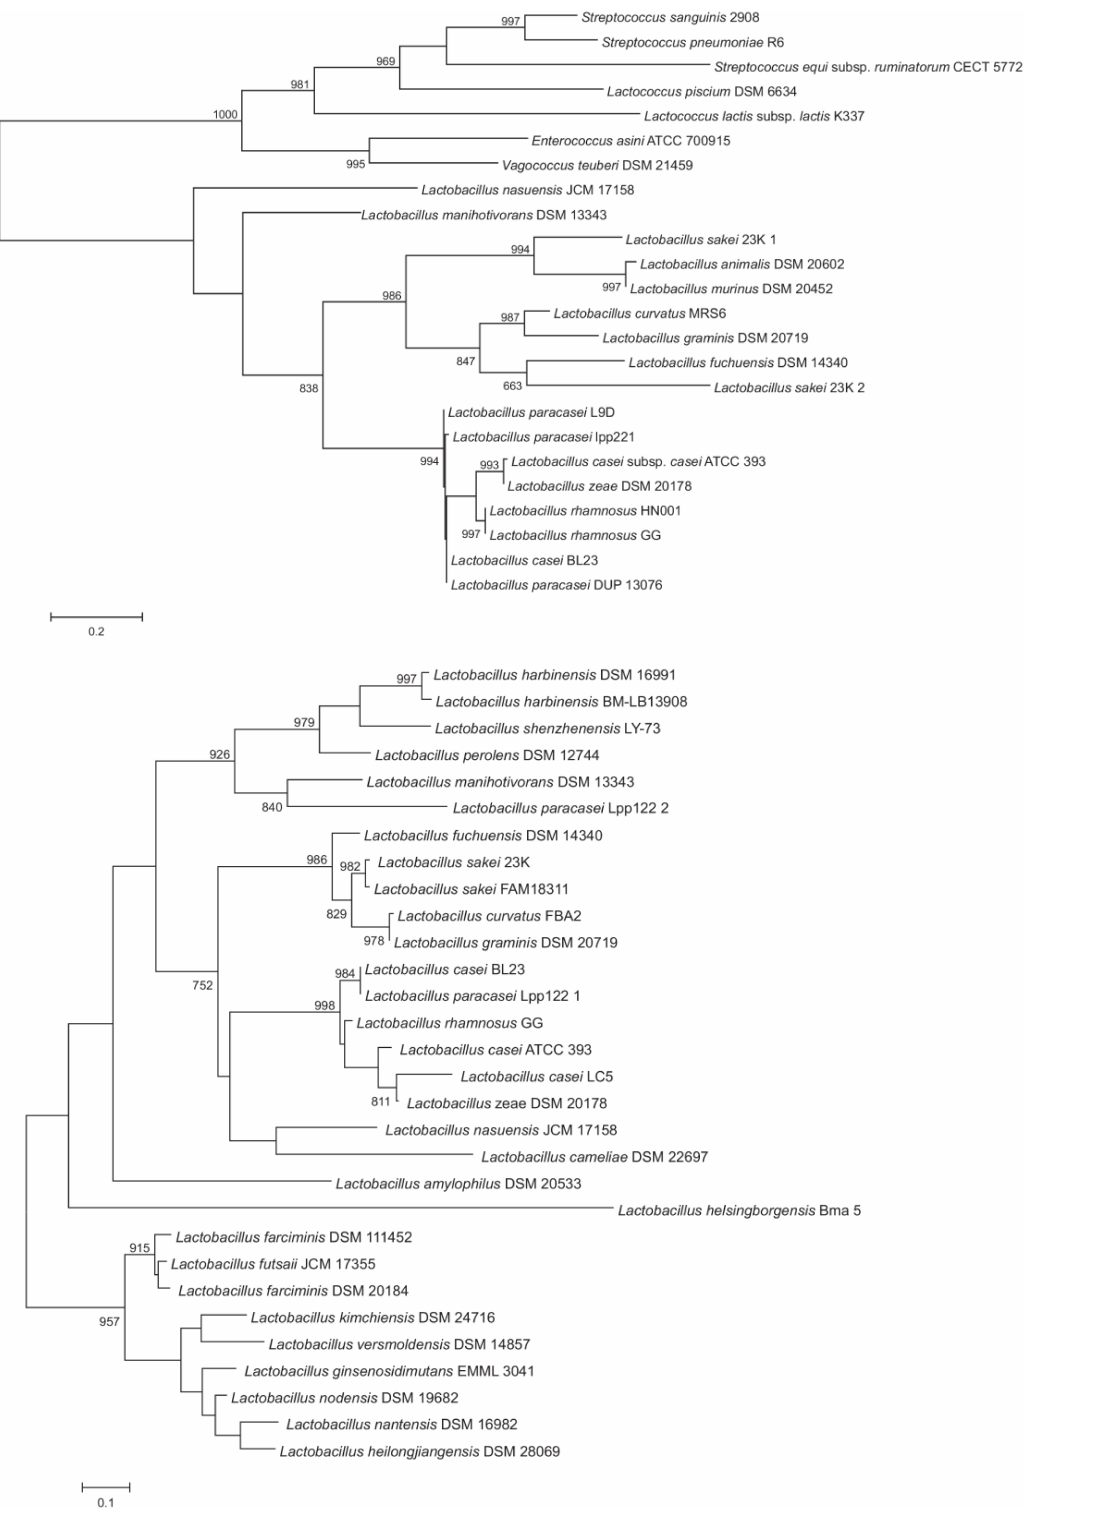
Frontiers in Microbiology |